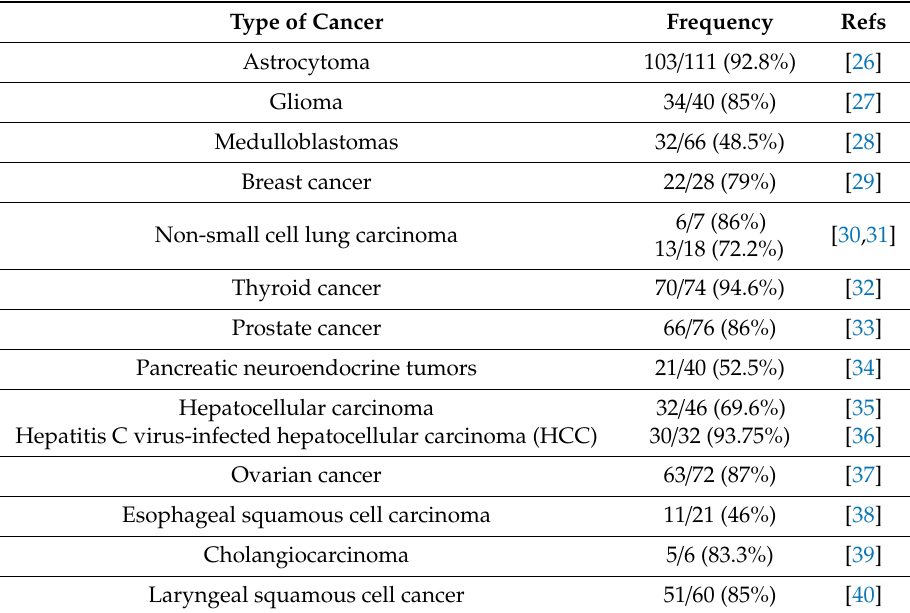
Table 1. Involvement of PARK7 in various types of